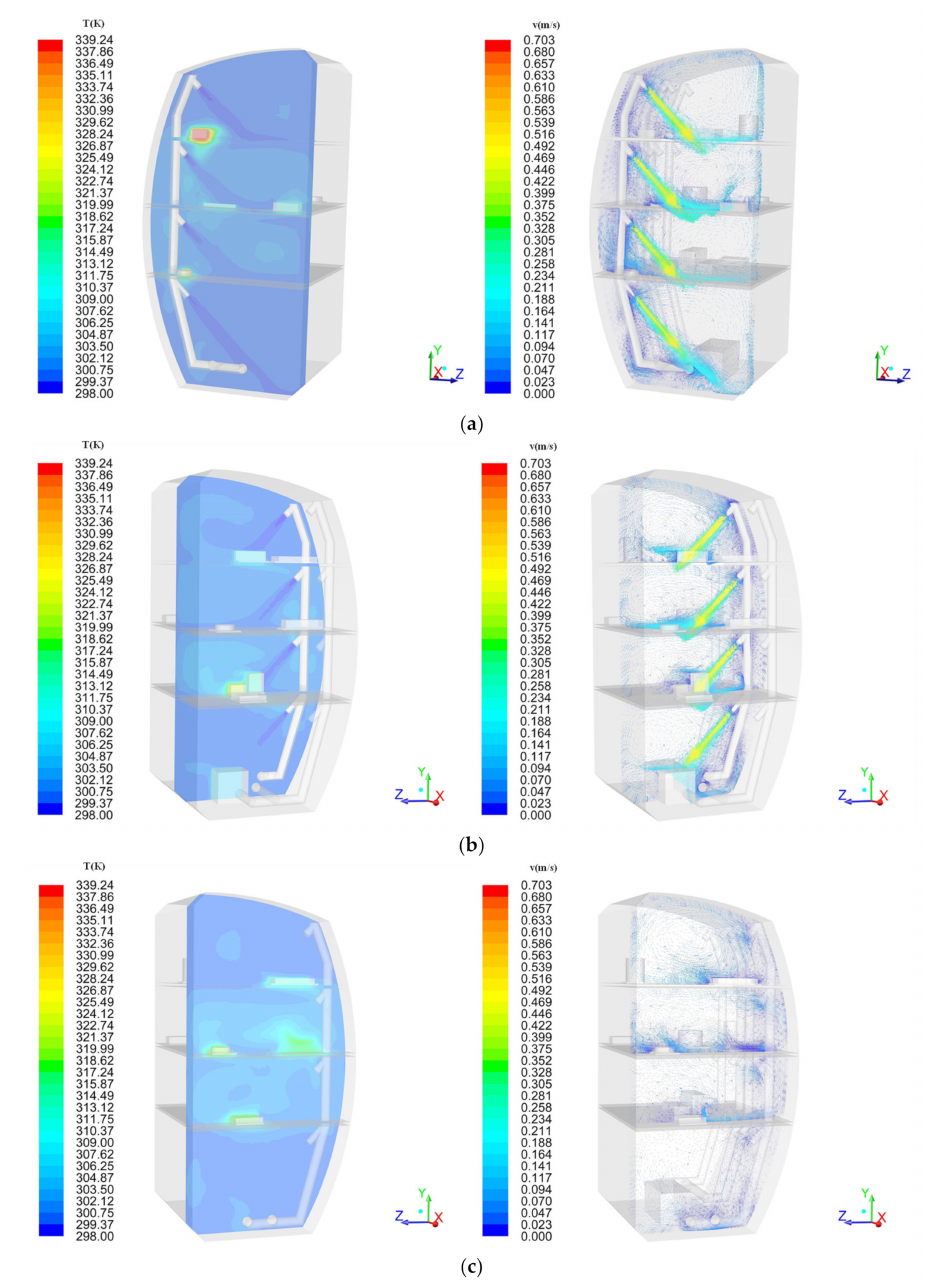
Figure 10. Temperature distribution and velocity vector of traditional 45 ◦ upper air supply. ( a ) x = 120 mm, ( b ) x = 600 mm, and ( c ) x = 900